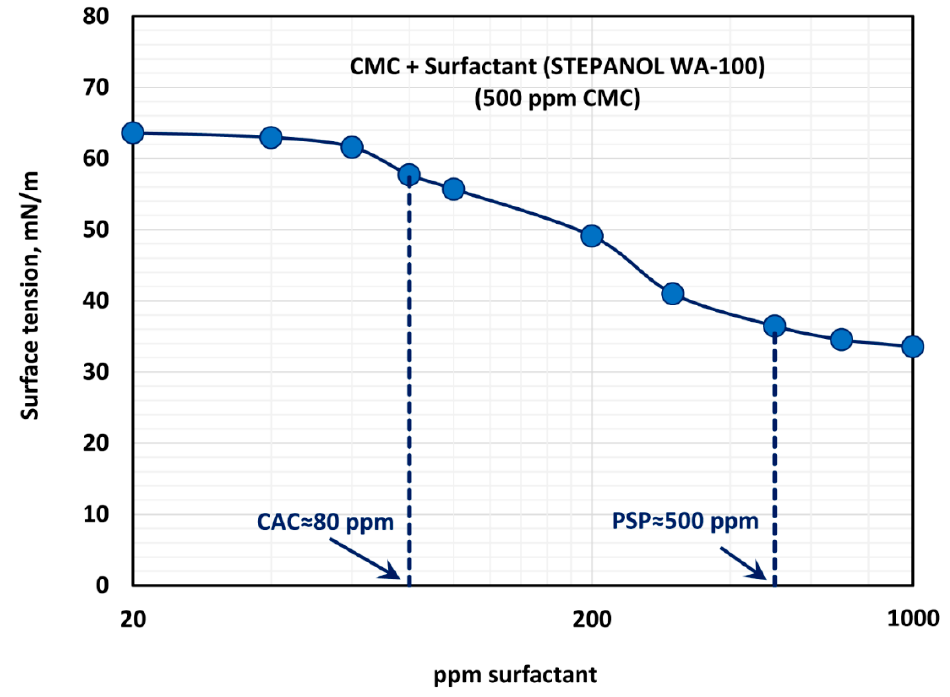
Figure 10. Variation of surface tension of surfactant-polymer solutions with the increase in surfactant (Stepanol WA-100) concentration, at a fixed polymer (CMC) concentration of 500 ppm.